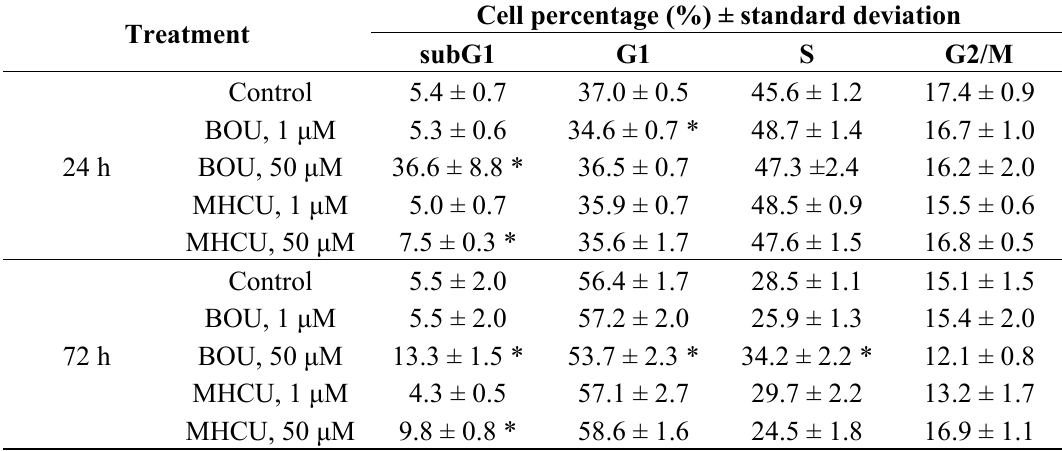
Table 1. Flow cytometric analysis of S W620 cells treated with BOU and MHCU at concentrations of 1 and 50 μM for 24 and 72